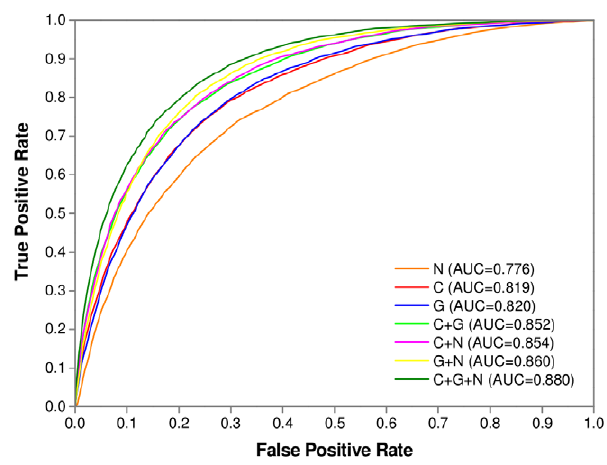
Figure 3. The ROC curves of different predictors tested on Dataset 1. Seven SVM-based predictors were built in terms of different feature combination (N/G/C=Network/Geometry/Conservation) and evaluated by a 5-fold cross-validation on Dataset 1.